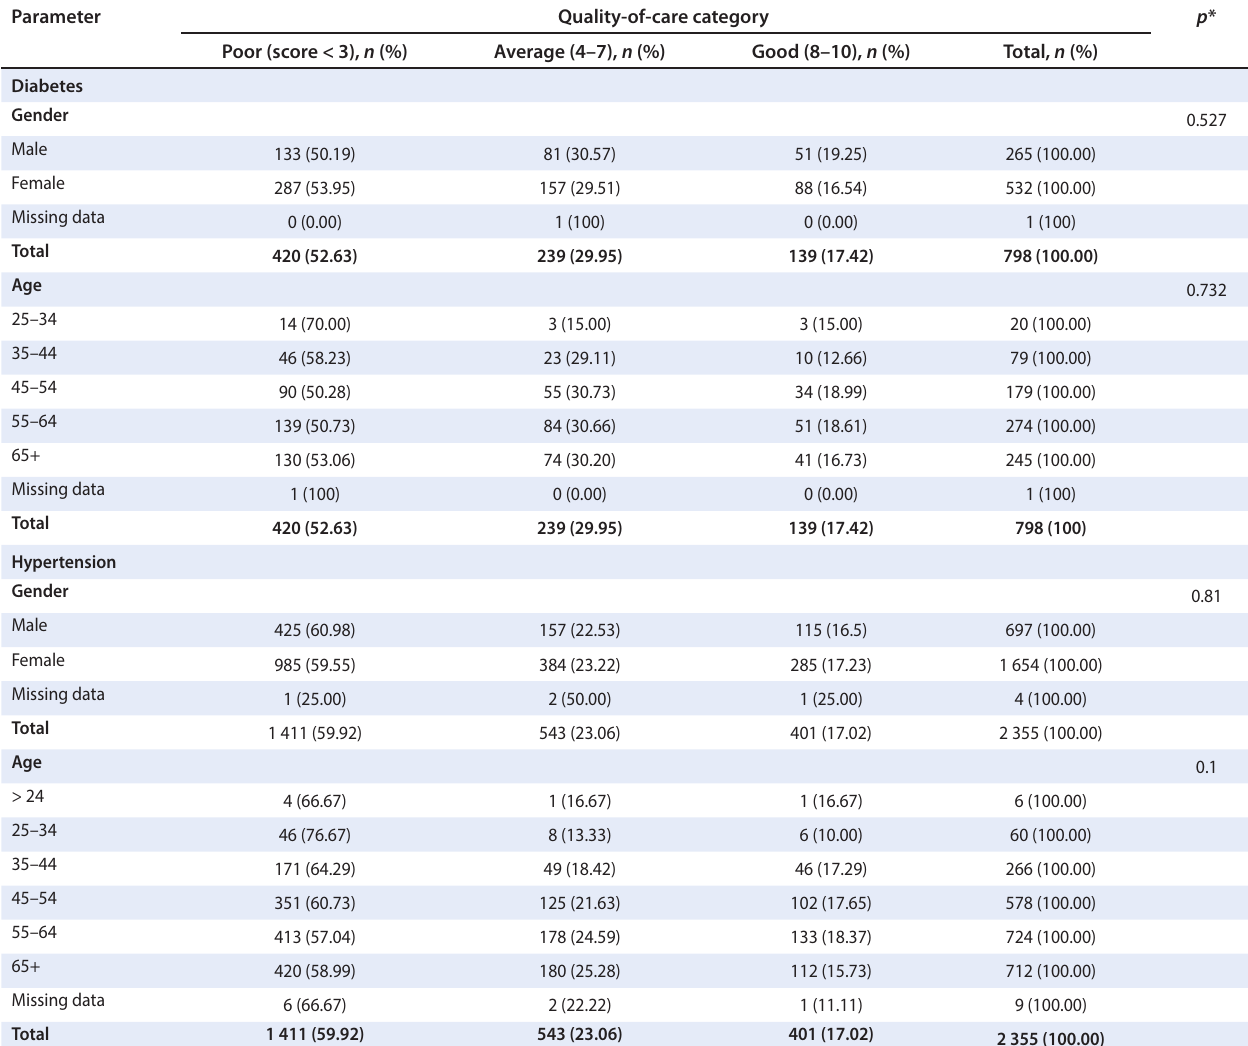
Table 2: Quality-of-care scores for diabetes and hypertension by gender and age group